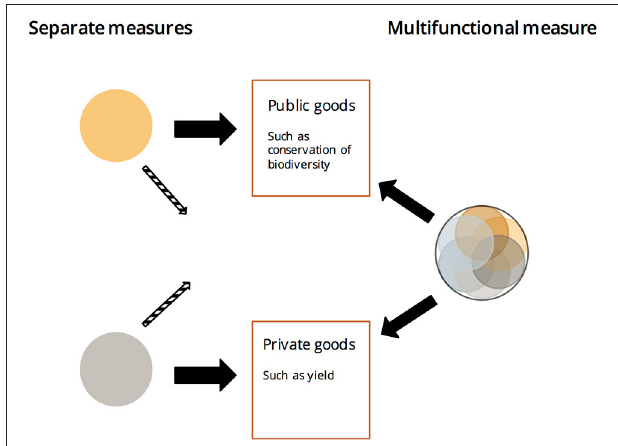
FIGURE 2 | A conceptual view of measures benefitting public and private goods separately, versus a multifunctional intervention, benefitting both public and private goods. The size of the arrows indicates the effect the measure has on the service, a specialized intervention targeting only one type of service might have a higher effect on that service than a multifunctional measure, targeting both public and private goods jointly. The striped arrows represent small fortuitous benefits on other types of ecosystem services. A measure with the objective to benefit yield through increased pollination may for example benefit also a rare insect